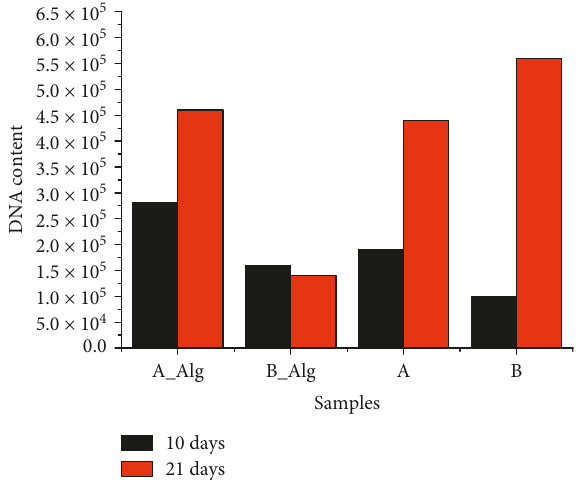
Figure 5: DNA content expressed by chondrocytes cultured for 10 and 21 days on the PHEMA samples (A and B) with and without